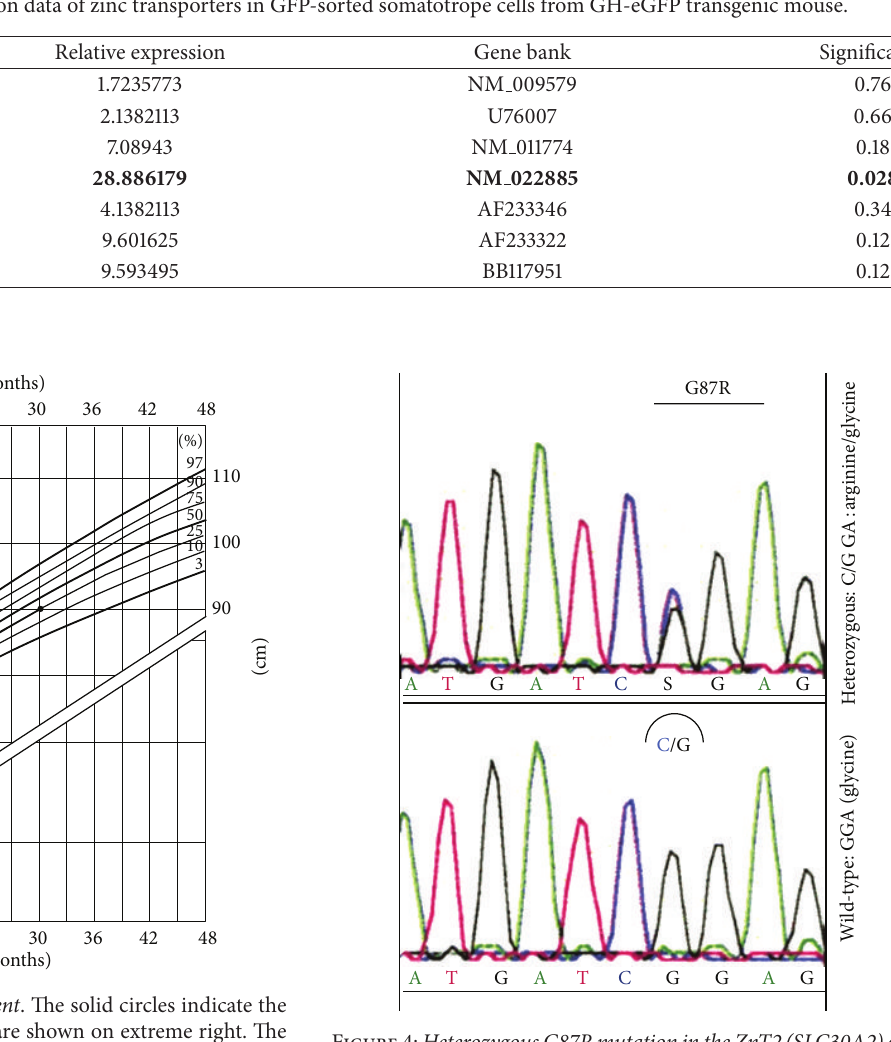
Figure 4: Heterozygous G87R mutation in the ZnT2 (SLC30A2) gene . Atposition87ofthe ZnT2(SLC30A2) gene,aheterozygousmutation G > C (Gly > Arg) is